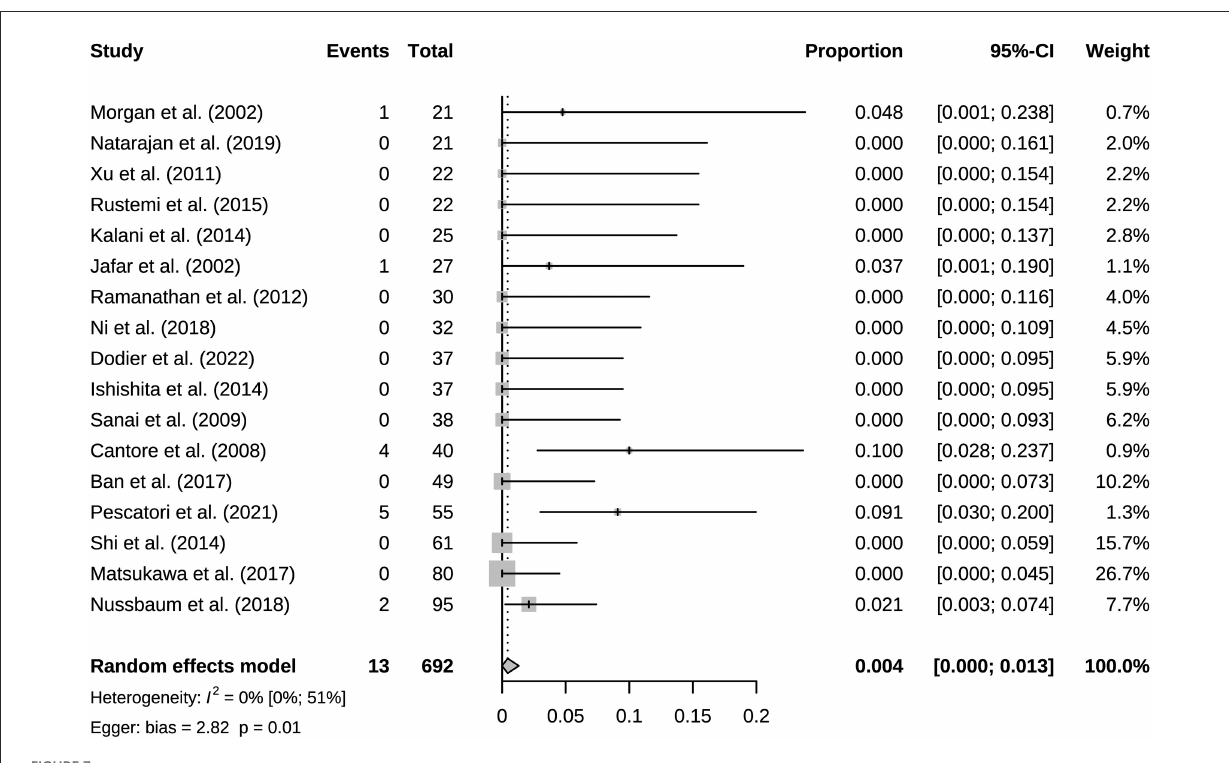
FIGURE7 Long-term follow-up surgery-related mortality of included